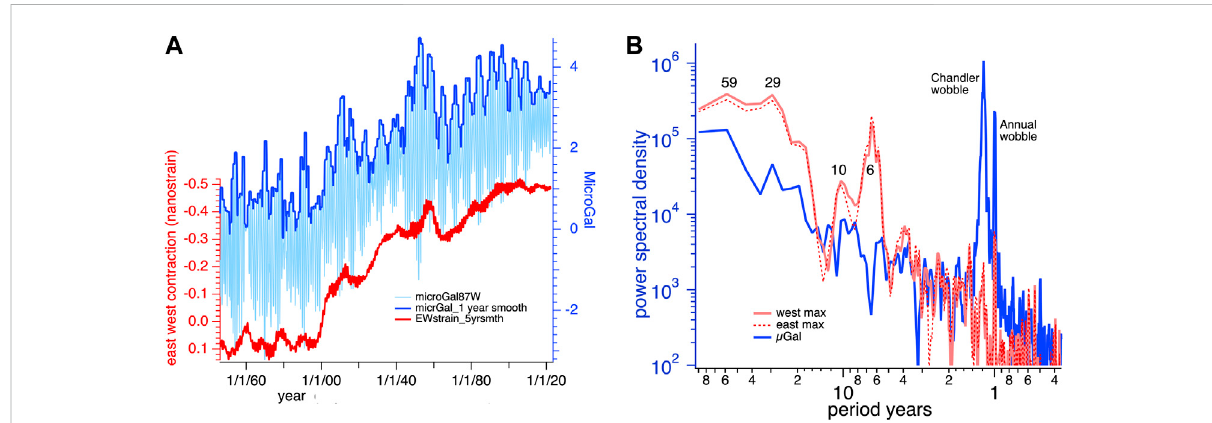
FIGURE 8 (A) E/Wstrainchanges(red)acrosstheCaribbeanplate1845 – 2022witha5 yearsmovingaverage, compared tovariations ingravity(light blue), and their peak annual value (dark blue). (B) Multi-taper spectral analyses of the raw gravity signal (blue) showing the Chandler and Annual peaks, compared to the spectral density of peak annual strain calculated for the E and W extremities of the Caribbean